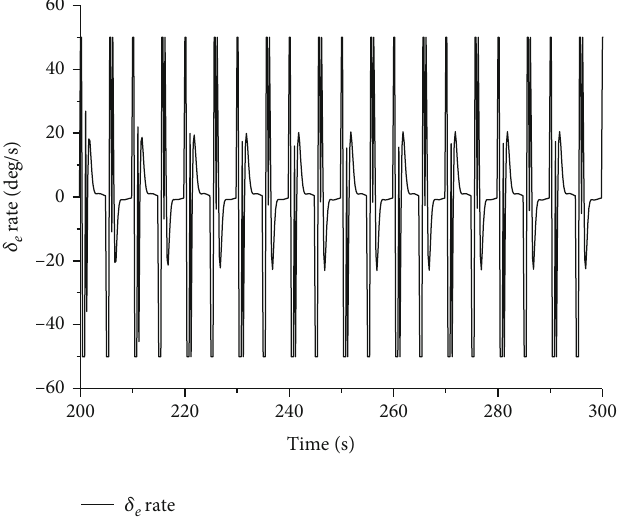
Figure 25: Elevator de fl ection rate with attitude